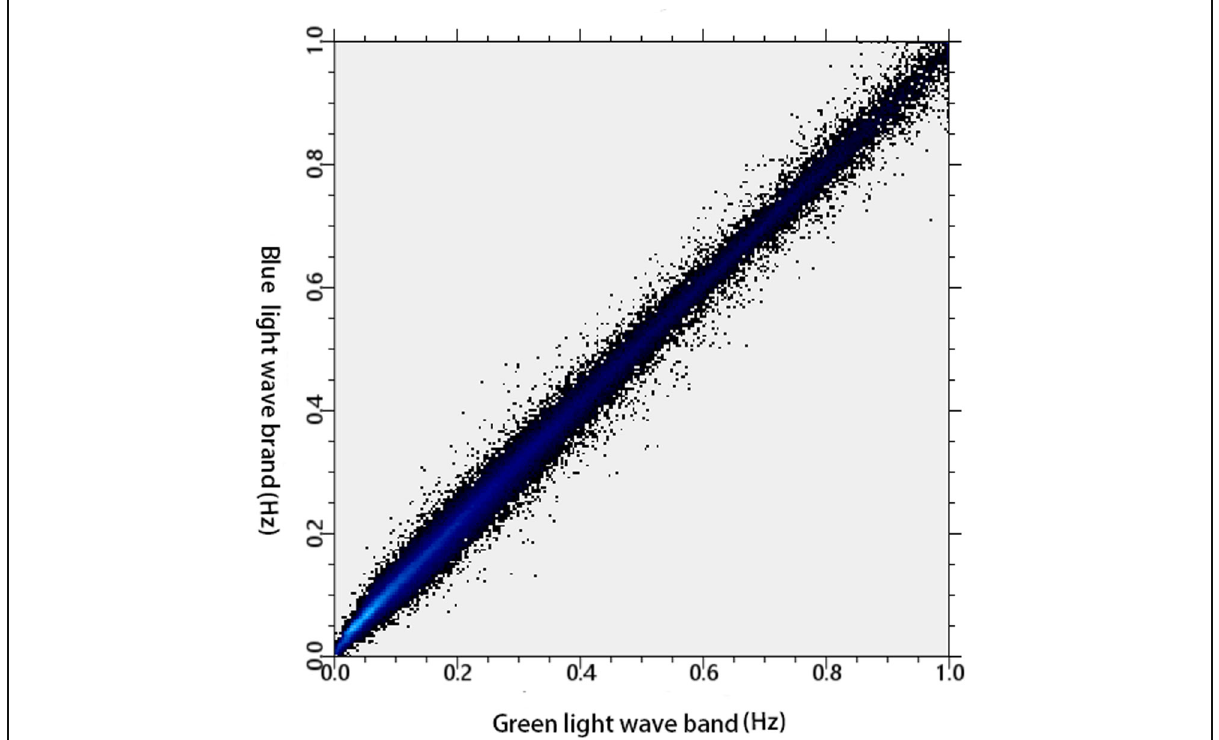
Fig. 10 Correlation analysis between green light and red light